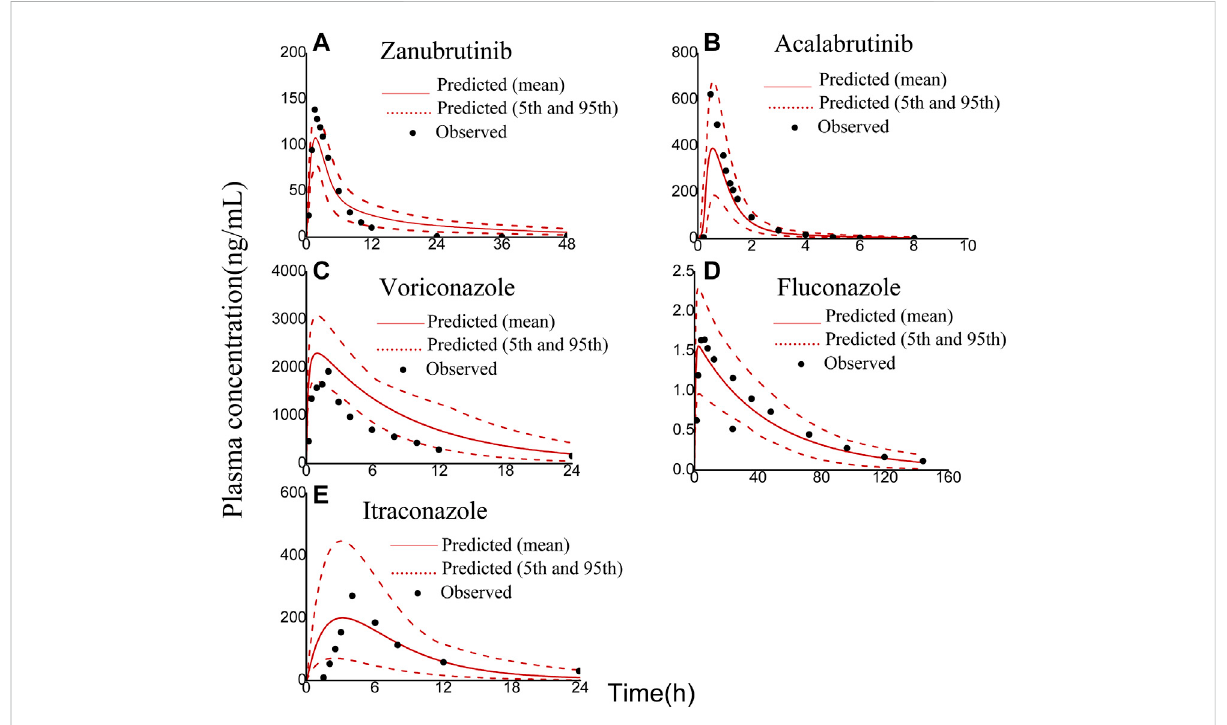
FIGURE 2 Observed (symbols) and physiologically based pharmacokinetic (PBPK) model simulated (solid lines) plasma concentration-time pro fi les of zanubrutinib, acalabrutinib, voriconazole, fl uconazole, and itraconazole: (A) 80 mg zanubrutinib oral; (B) 100 mg acalabrutinib oral; (C) 200 mg